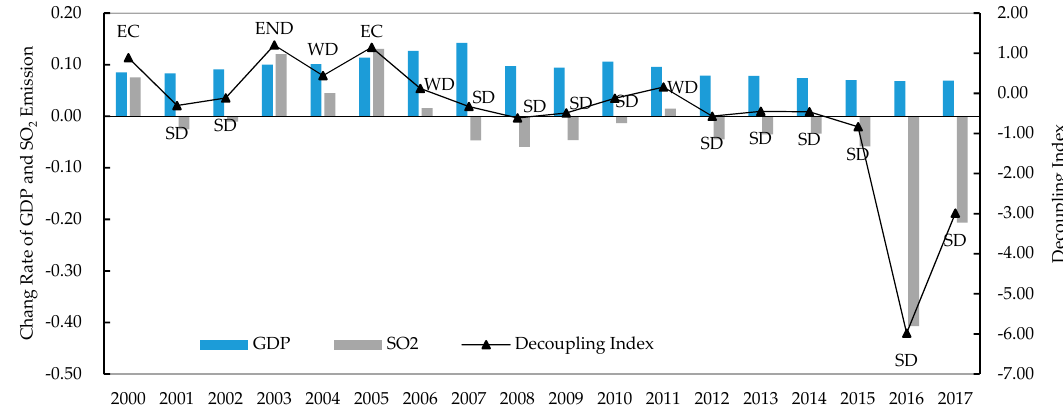
Figure 1. Decoupling conditions in China 2000–2017.